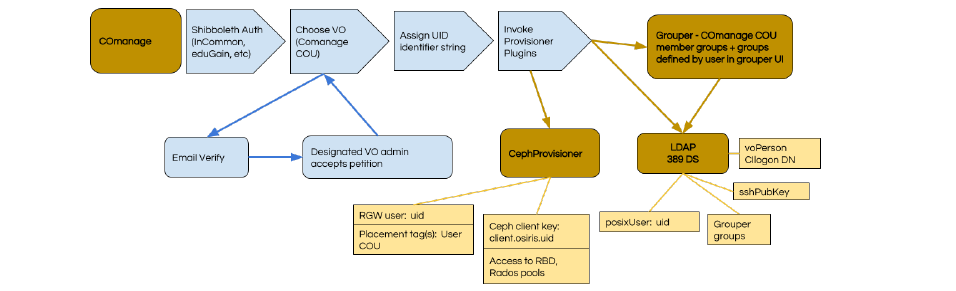
Figure 1. COmanage flow for a new user authenticating to our gateway and joining a virtual organization. Following verification and approval the COmanage provisioning plugins translate identity and access information as appropriate for services including LDAP, Grouper, and